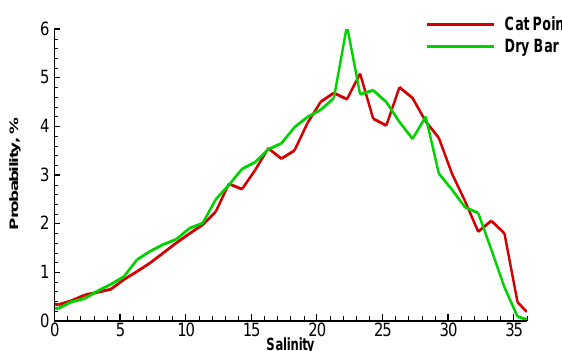
Figure 7. Probability distribution of salinity at Cat Point and Dry Bar.